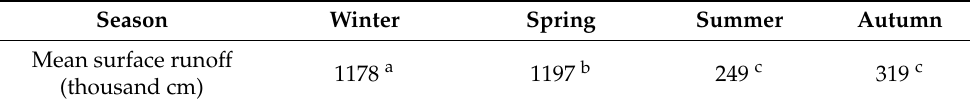
Table 5. Testing influence of season on surface